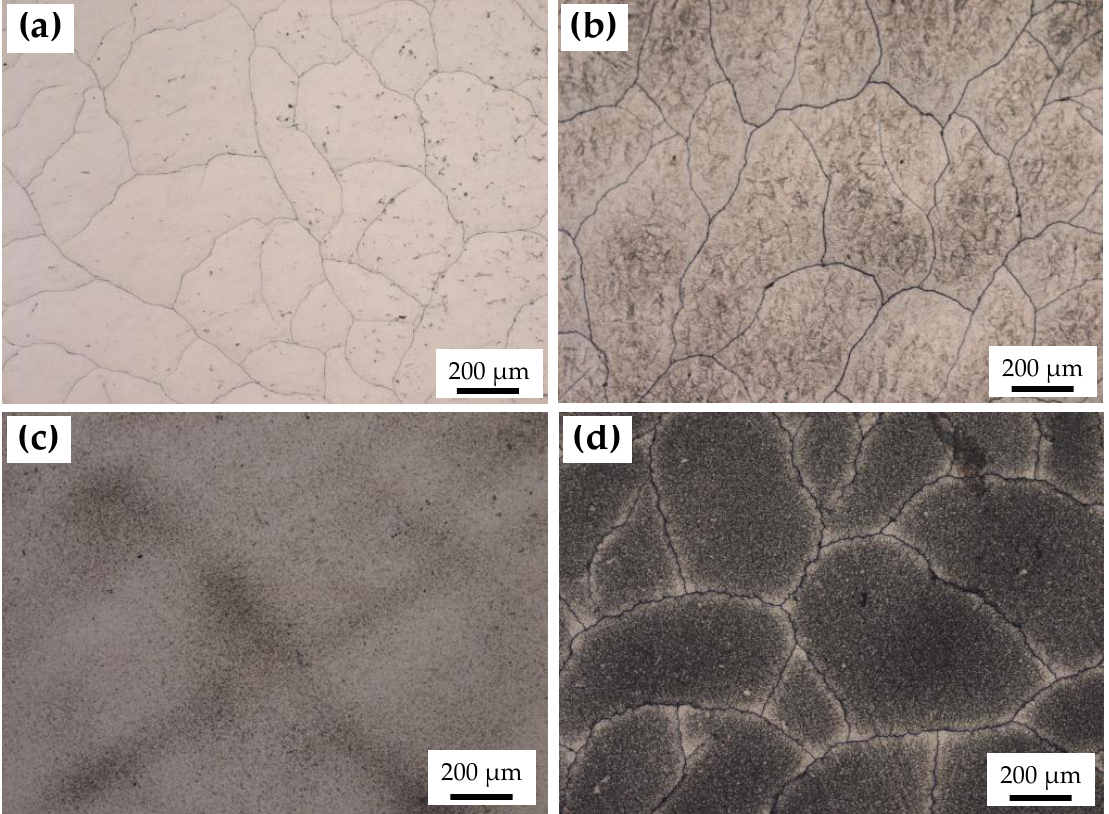
Figure 6. Surface morphologies of the WTC samples after ELM-like thermal loading. ( a ) As-sintered at 330 MW/m 2 ; ( b ) As-sintered at 440 MW/m 2 ; ( c ) As-forged at 330 MW/m 2 ; ( d ) as-forged at 440 MW/m 2 .